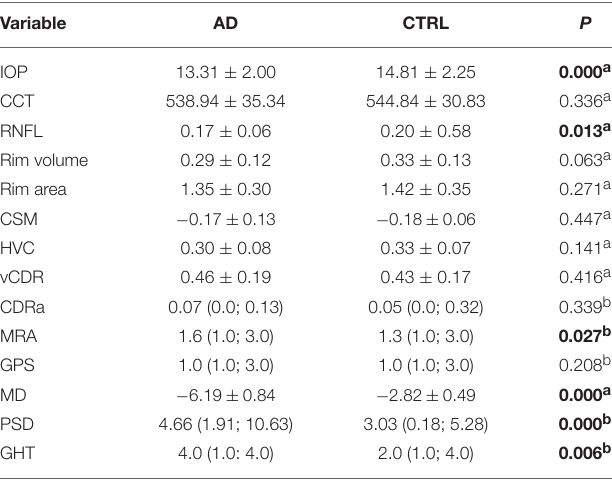
TABLE 2 | Statistical analysis of the ophthalmological parameters considered. Variable